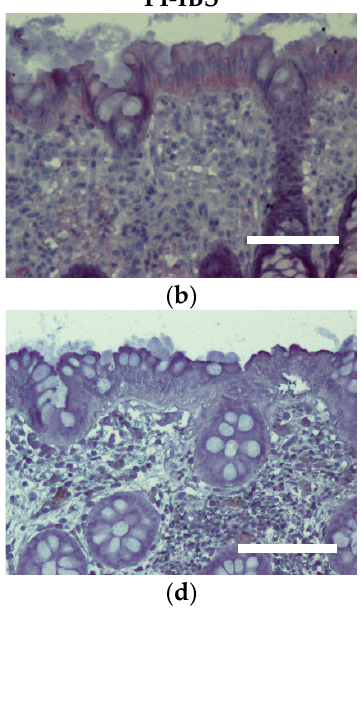
Figure 7. Immunohistochemistry of Th1 cytokines (red) in the colon mucosa of controls and PI-IBS patients of IL-1 β ( a , b ), IL-6 ( c , d ), IL-22 ( e , f ), INF γ ( g , h ) and TNF α ( i , j ), (counterstaining with hema- toxylin = violet). Staining for IL-1 β and IL-22 intensified in surface enterocytes in PI-IBS. Bar = 100 µm.